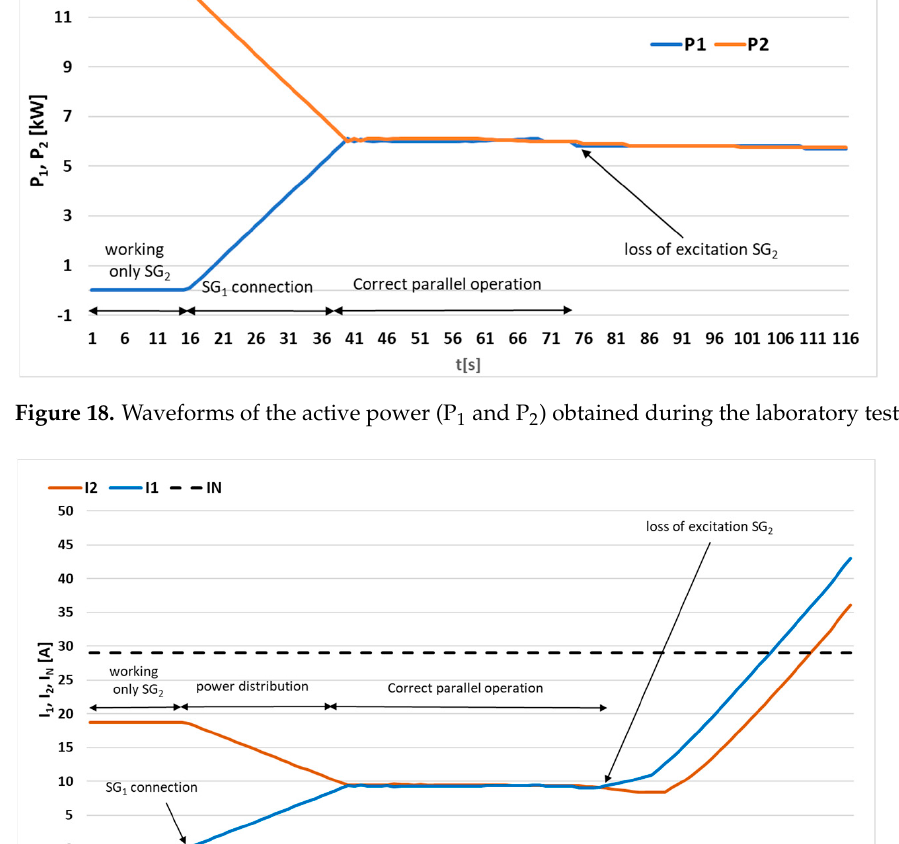
Figure 17. Waveforms of the reactive power (Q 1 and Q 2 ) obtained during the laboratory tests.